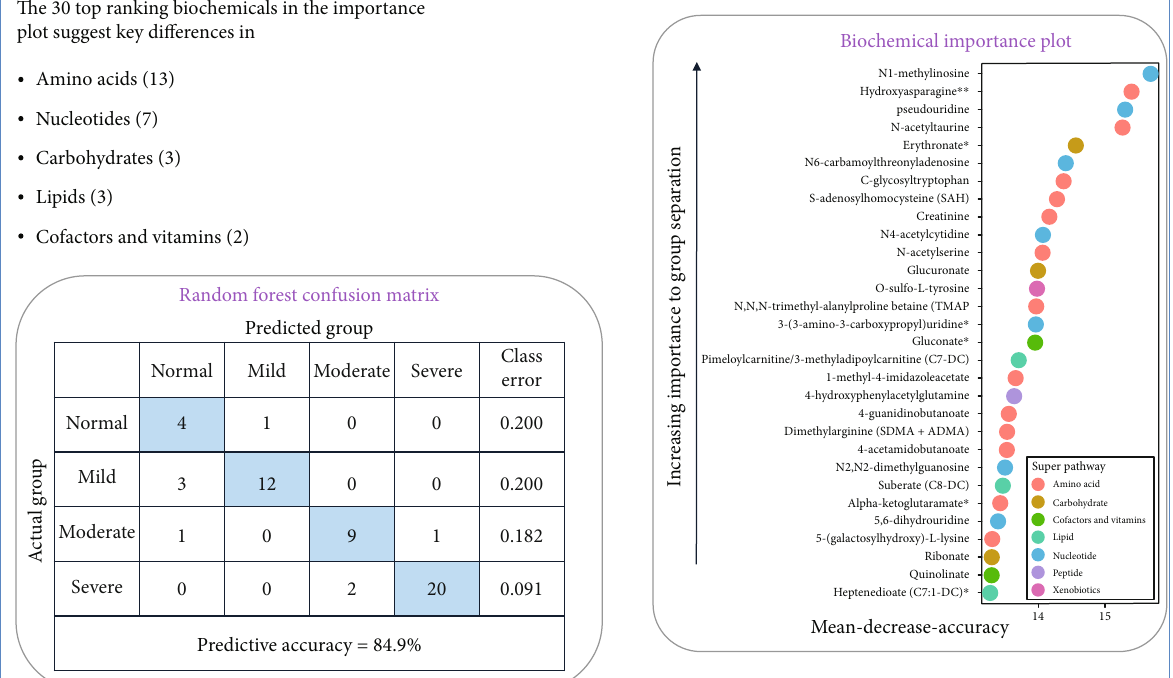
Figure 3: Random forest analysis of serum from subjects with normal kidney function, mild nephropathy, moderate nephropathy, and severe